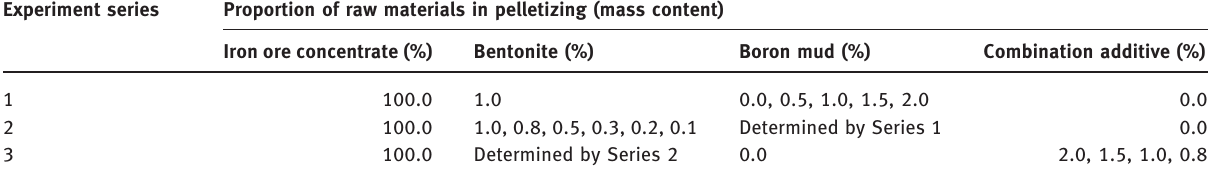
Table 2: Experimental scheme of boron mud used in pelletizing. Experiment